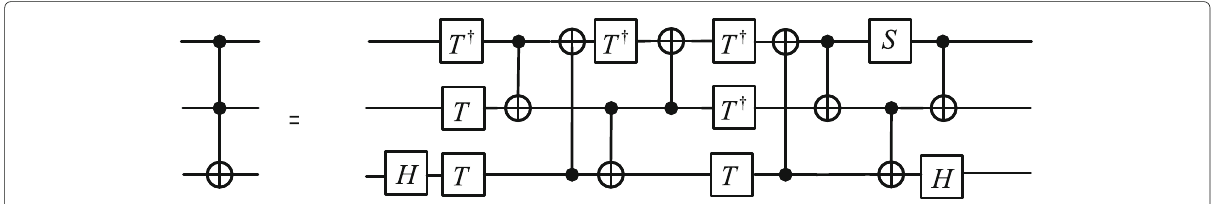
Fig. 4 The decomposition of Toffoli gate in (Amy et al.